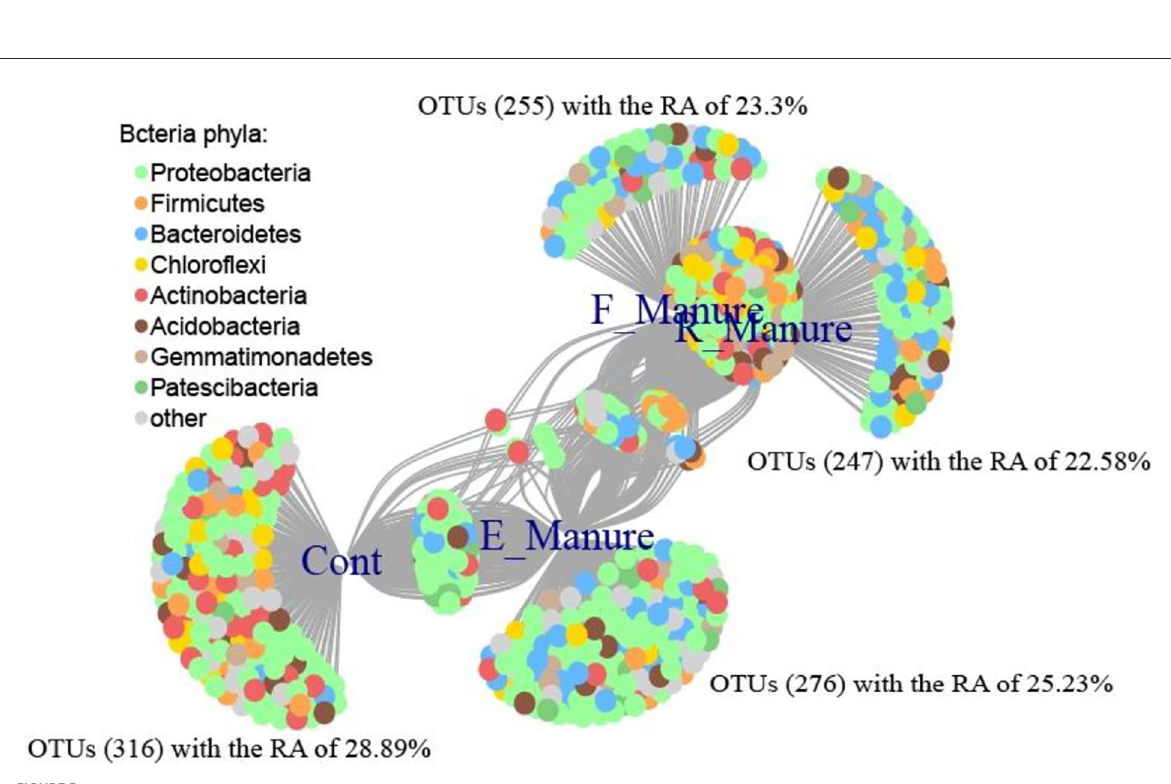
FIGURE5 Bipartite network showing the associations between the four treatments of fertilization and 1,094 significantly associated OTUs ( P < 0.01). Edges (node connection) show the association of individual OTUs with each treatment of fertilization. OTUs are colored by phylum. The network analysis was visualized using